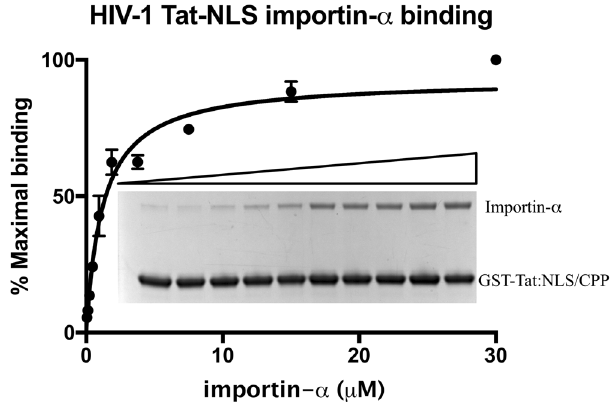
Figure 6. Quantitative GST-pull down for binding affinity determination. Glutathione agarose containing the GST-Tat:NLS/CPP incubated and washed with two-fold serially diluted importin- α (initial concentration of 30 µ M). Samples analysed by SDS-PAGE and images recorded using BioRad Gel Doc system were processed from triplicate gels and processed in ImageJ and analysed using one-site specific binding in Prism 7.0. A representative gel showing binding is included, and the original, uncropped gel is provided in Supplementary Figure 2.